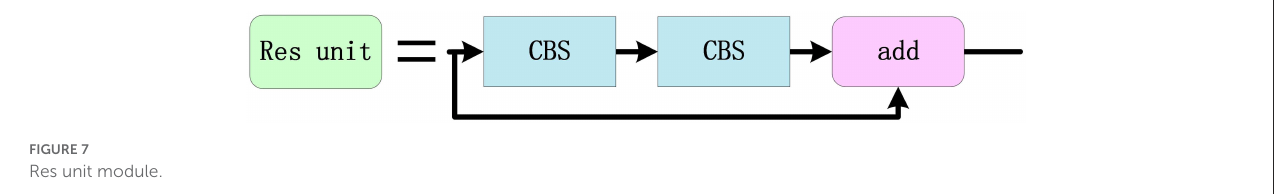
FIGURE7 Res unit module.